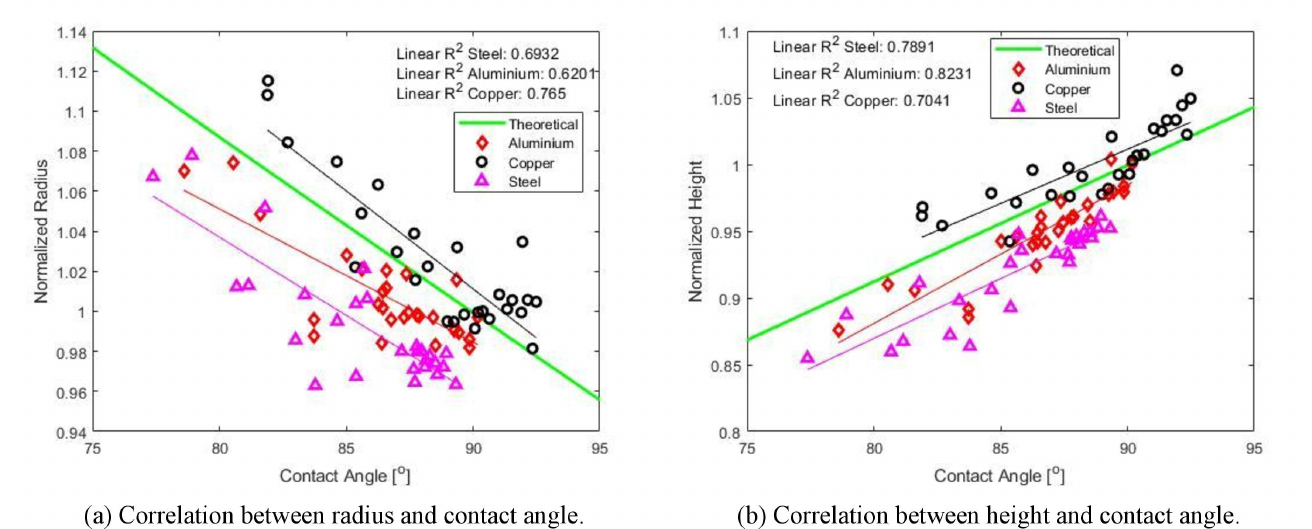
Figure 3. Droplet radius and height as a function of contact angle. ( a ) shows the normalized radius as a function of the contact angle. ( b ) shows the normalized height as a function of a contact